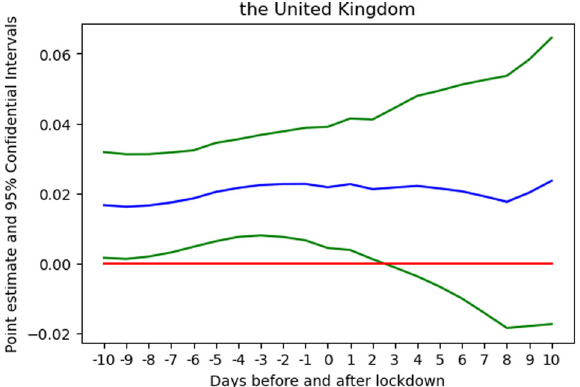
Fig. 5 Estimated coef fi cients of the change in trend at 21 supposed break points. Notes: The blue line plots 21 estimates of the coef fi cient of the change in preference at a supposed breakpoint, while the green lines refer to the corresponding con fi dence intervals. The blue line is hump-shaped with the peak, roughly around t = 0. It shows that the change in preference was most marked at around the actual breakpoint (to be precise at t = − 1). This result suggests that the lockdown sparked off an upward change in the preference for nostalgic music. Source: Author ’ s analysis and illustration of Spotify data.